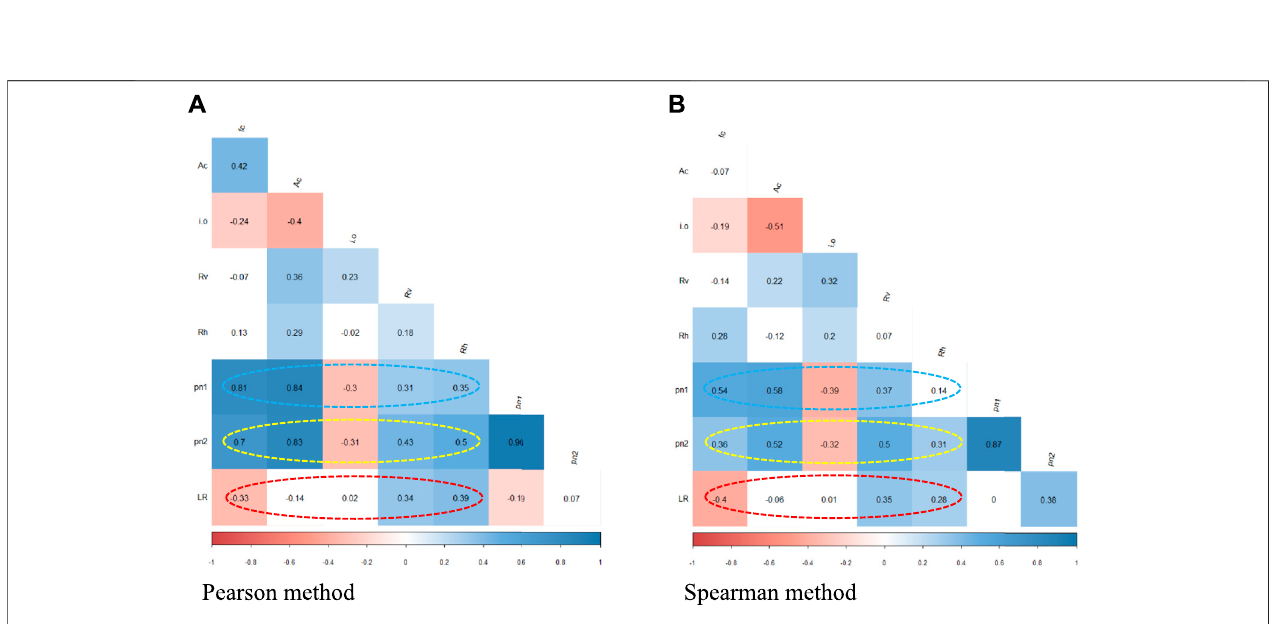
FIGURE 7 | Correlation coef fi cients for the key test variables. (A) Pearson method. (B) Spearman method.